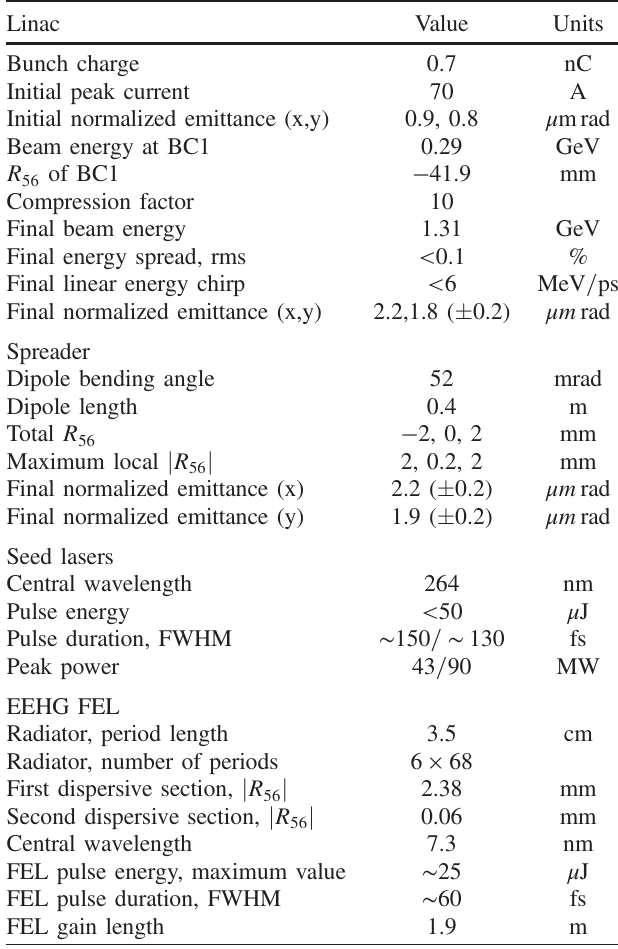
TABLE I. List of Fermi parameters